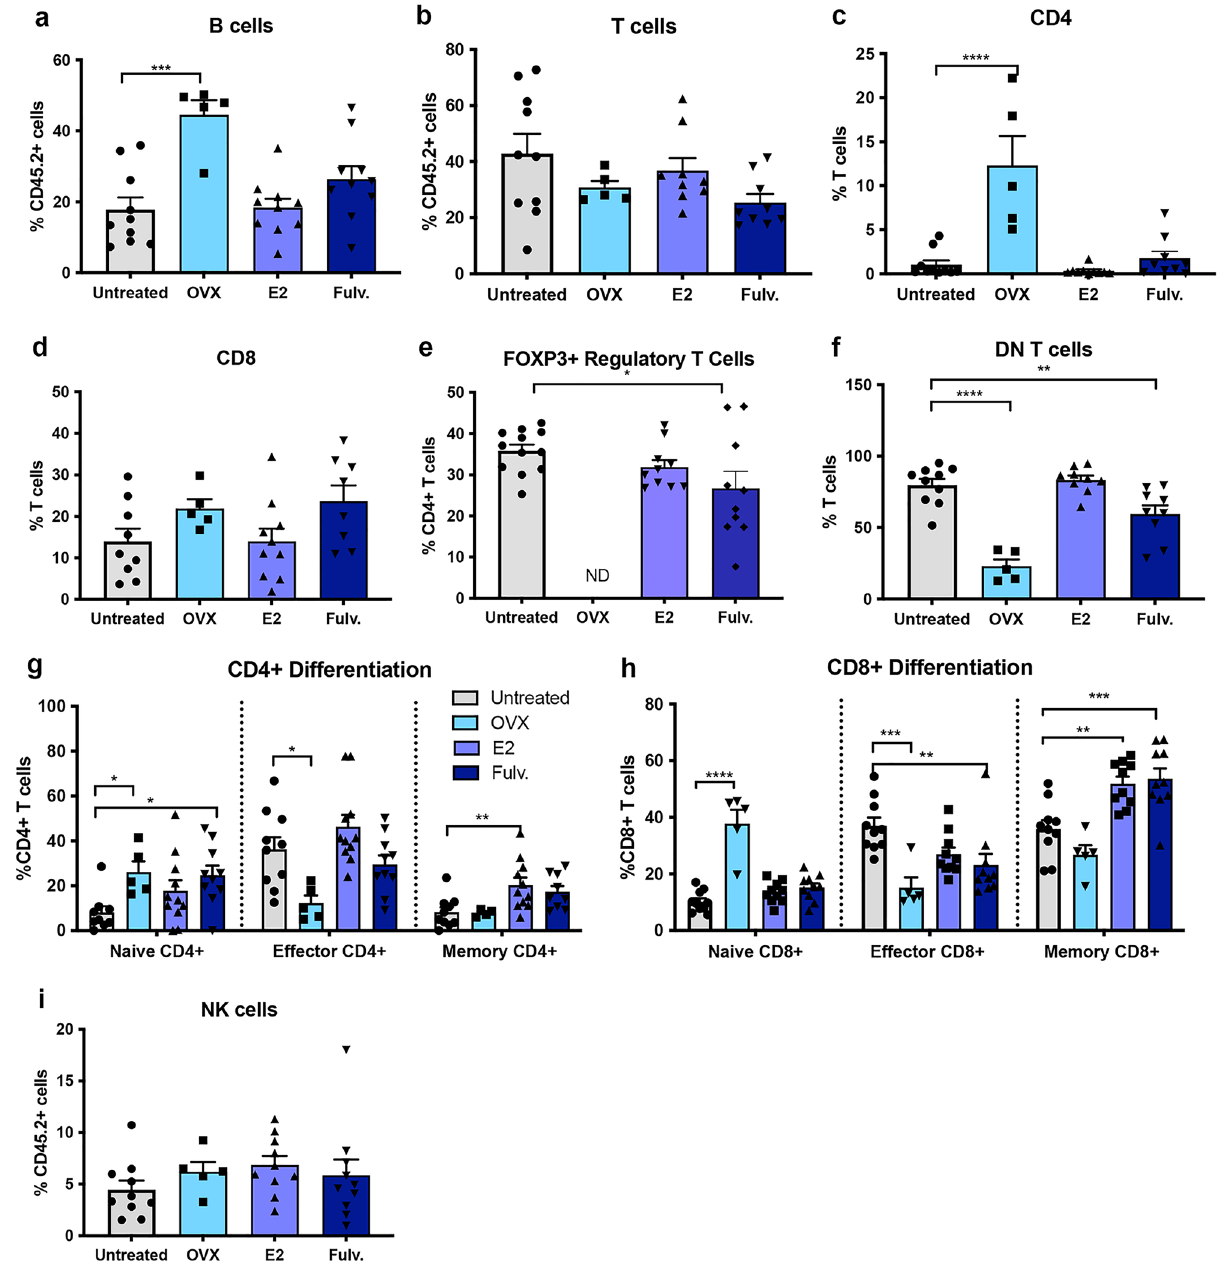
Figure 6. Effects of estrogen, oophorectomy and fulvestrant on the blood adaptive immune cells. Mice were either untreated, ovariectomised (Ooph) or treated for 6 weeks with estrogen (E2) or Fulvestrant (Fulv). ( a ) B cells, ( b ) T cells, ( c ) CD4 + T helper cells, ( d ) CD8 + cytotoxic T cells, ( e ) FoxP3 + regulatory T cells, ( f ) CD4- CD8- T cells, ( g ) CD4 + differentiation status, ( h ) CD8 + differentiation status and ( i ) NK cells. Results are expressed percentage of immune cells (mean ± SEM). n = 5–17 mice/group. Data was analysed using a Turkey multiple comparisons one-way ANOVA if confirmed Gaussian distribution, or Kruskal–Wallis